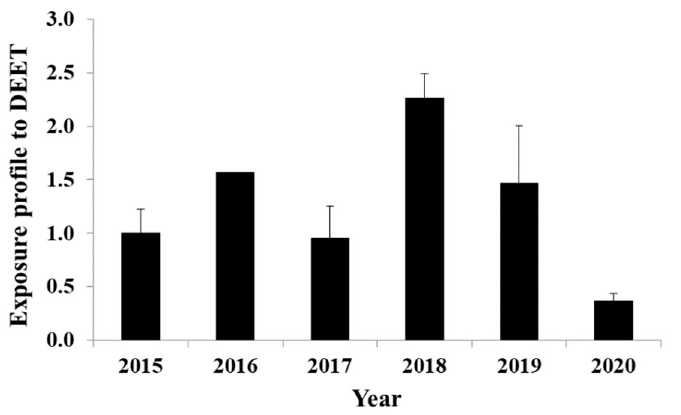
Figure 5. Exposure to N, N-diethyl-meta-toluamide (DEET) adjusted to 2015, back-calculated from 3-ethyl-carbamoyl benzoic acid concentrations in influent wastewater collected in Athens.